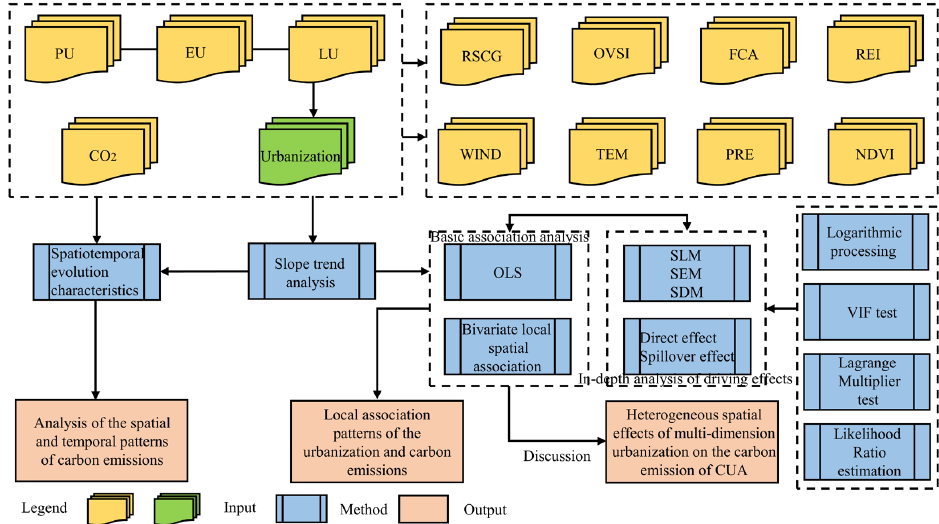
Figure 2. The technical route of the study .